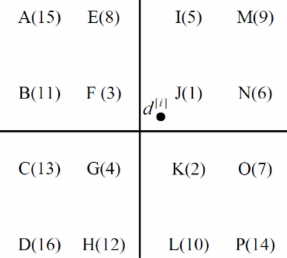
Figure 3. Example of the closest order of the constellation points with 16 quadrature amplitude modulation (QAM) from d [ i ]